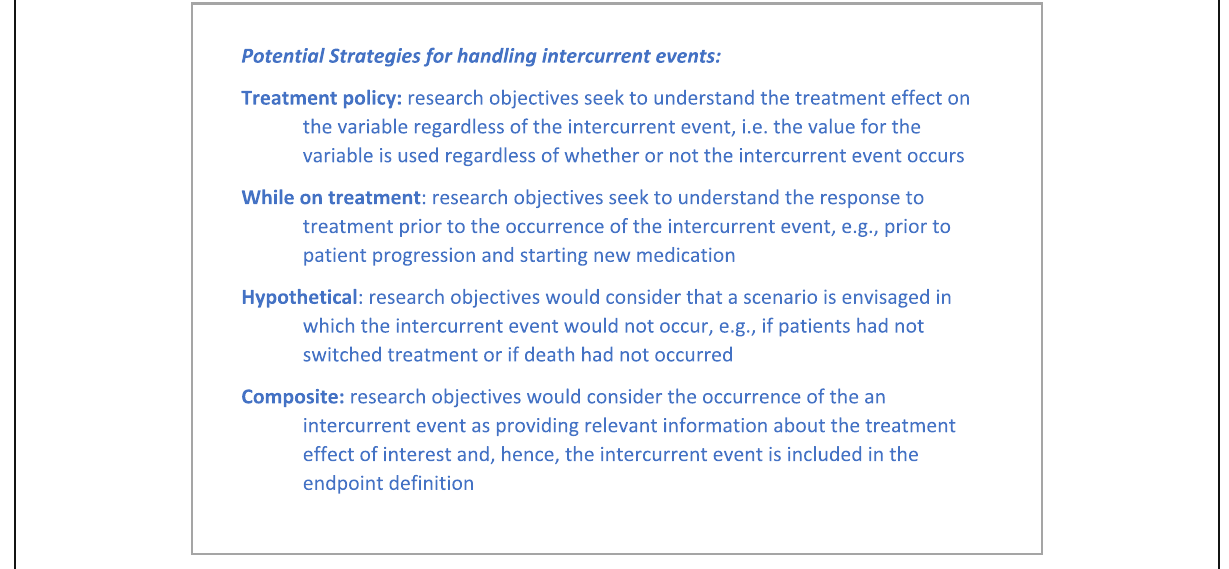
Fig. 2 Definitions for strategies for handling intercurrent events from ICH E9 (R1) addendum